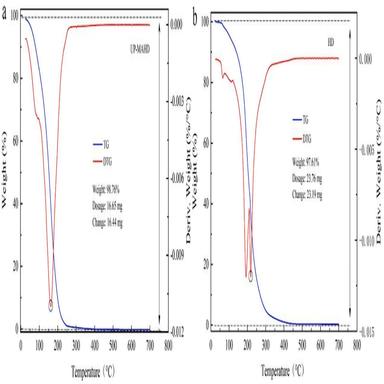
TG and DTG of PKSSEO, UP-MAHD (a), HD (b).